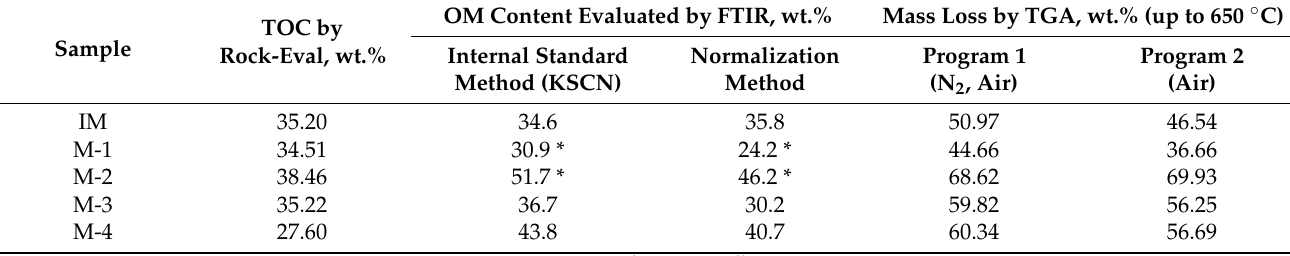
Table 3. Evaluation of organic matter (OM) content and composition in kerogen samples by Rock-Eval pyrolysis, TGA and FTIR spectroscopy in transmission mode (0.8 wt.% sample in KBr pellet) in the presence of the internal standard KSCN (0.5 wt.% KSCN at KBr pellet).